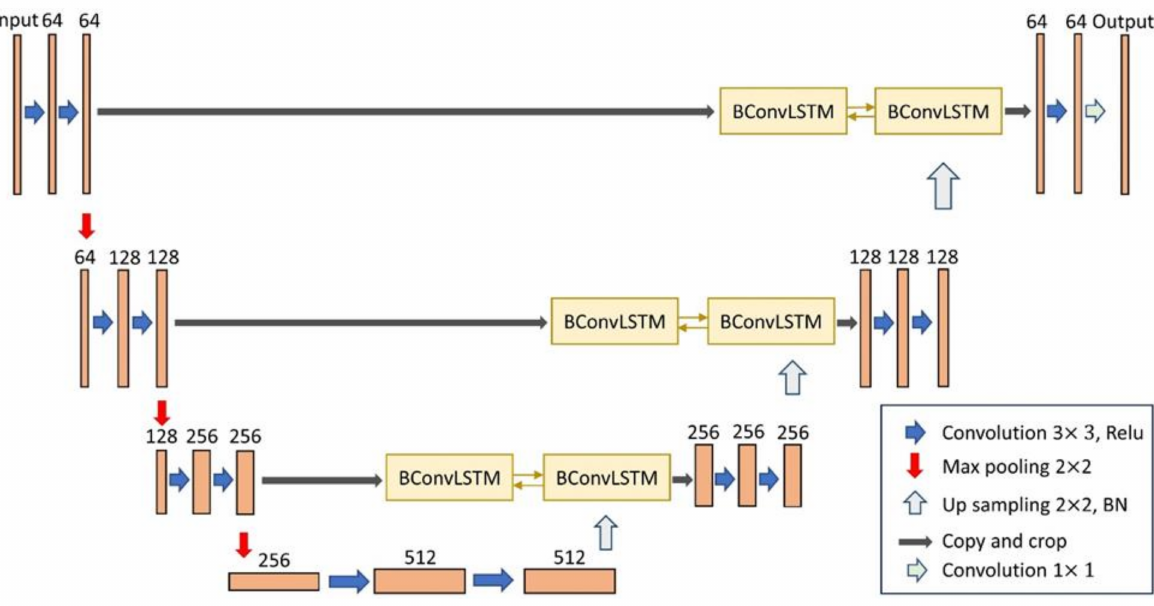
Figure 3. BCL-UNet model without any dense connections and with BConvLSTM in the skip